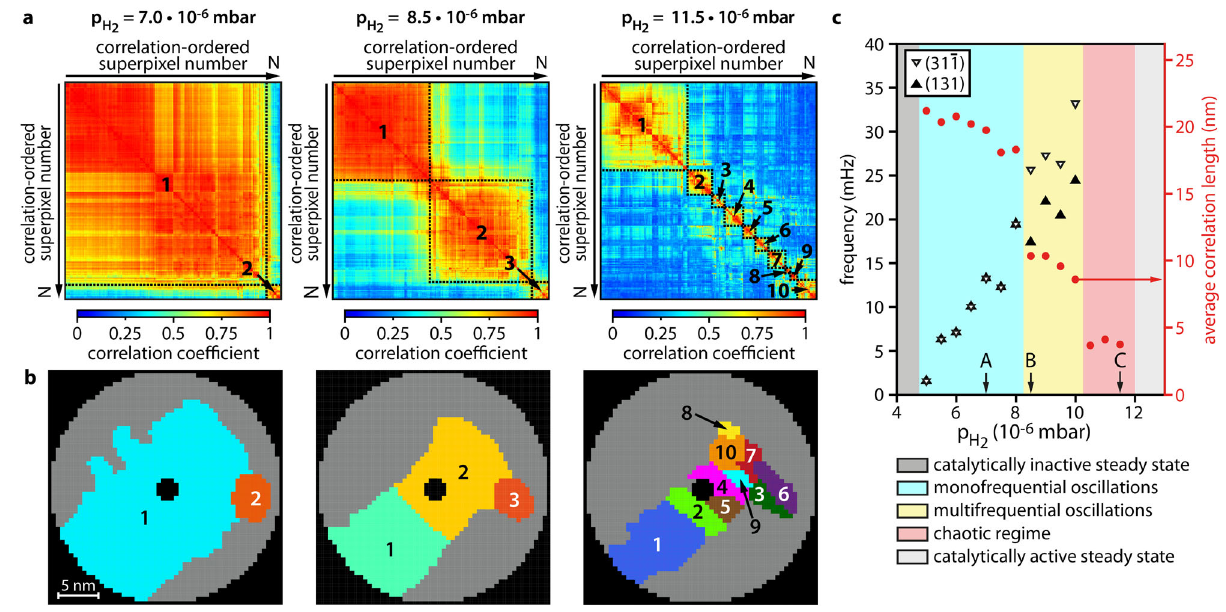
Fig. 3 | Spatial correlations at constant p O2 =4.4×10 − 6 mbar and 453K. behaviour, with the borders between the clusters marked; b Correlation map dis- a correlationcoef fi cientmatrixsummarisingthecorrelationbetweenexperimental playingthenumberedandcolourmarkedindividualclusters. c Averagecorrelation length values (right vertical scale) for different hydrogen pressures are plotted as timeseries of each individual super pixel (8×8 pixels), the colour represents the redcirclestogetherwiththeoscillationfrequenciesfromFig.2d(leftverticalscale). value of the correlation coef fi cient. (Left) p H2 =7.0×10 − 6 mbar, (middle) − 6 mbar, (right) p − 6 mbar. The superpixels are ordered p Black marked arrows indicate the p H2 -values corresponding to a H2 =8.5×10 H2 =11.5×10 according to spatial clustering, grouping surface regions with highly correlated